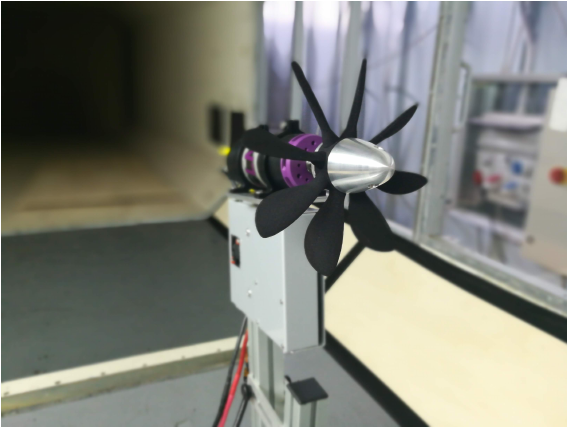
Figure 10. The propeller installed in the wind tunnel.